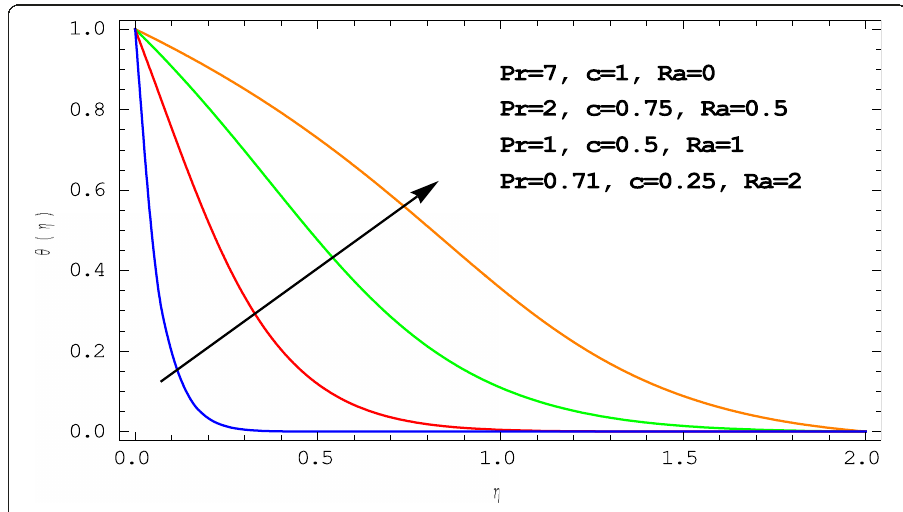
Fig. 3 Fluid temperature for different values of Pr, c , and